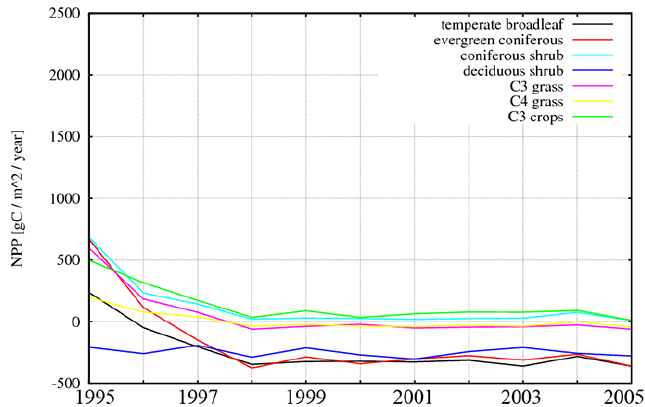
period 1995 to 2005